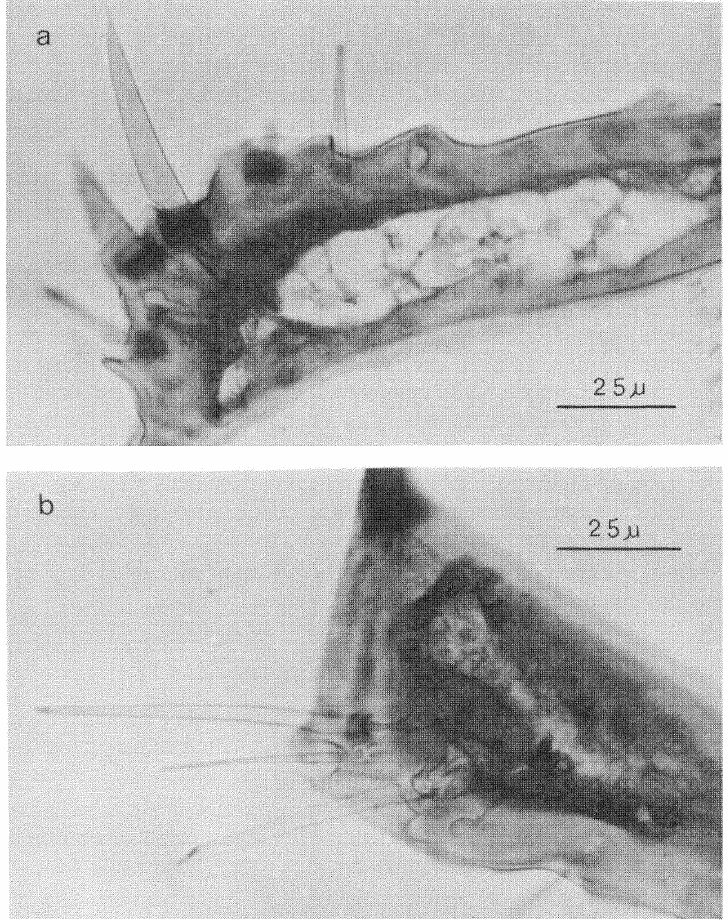
Figure 7. Longitudinal section through pygidial plate (a) and last exposed ster- nite (b) of a Cerapachys worker. The structure and innervation of the setae suggest that they function as mechano